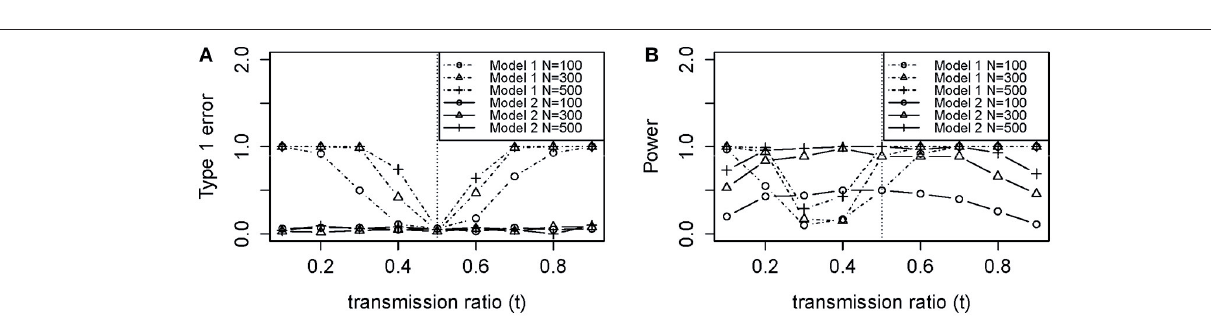
FIGURE 1 | Log ratio of (A) RR and (B) LRT P -values for models 1 (Unadjusted) vs. 2 (Adjusted).